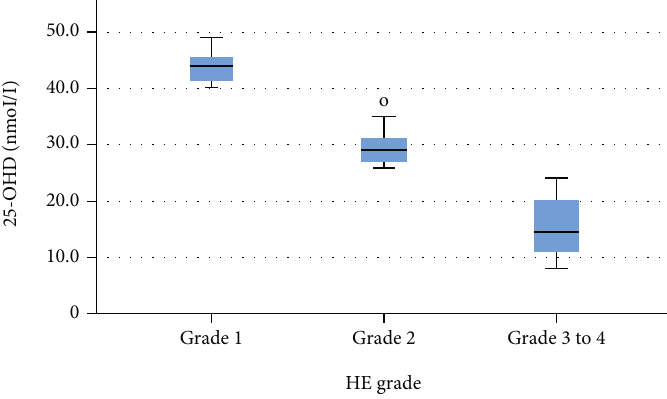
Figure 6: Comparison of 25-OHD level in di ff erent HE grades (A fifi , Hussein, and Rizk, 2020). Table 10: Comparison of 25-OHD levels in those who died and Table 11: Showing cut-o ff values of 25-OHD for survival in the HE those improved in the HE group.